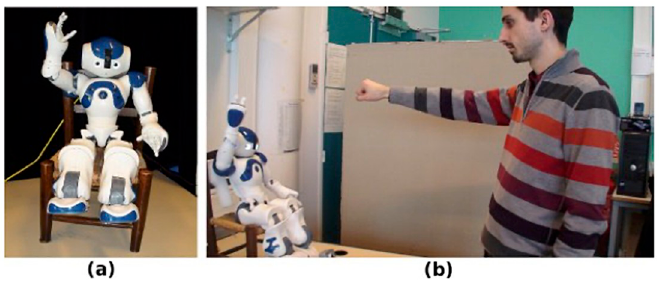
Fig 1. Experimental setup. (a) the NAO robot, (b) NAO Interacting with a human